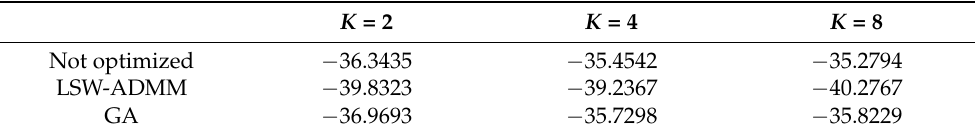
Table 4. AISL comparison before and after optimization (unit: dB).